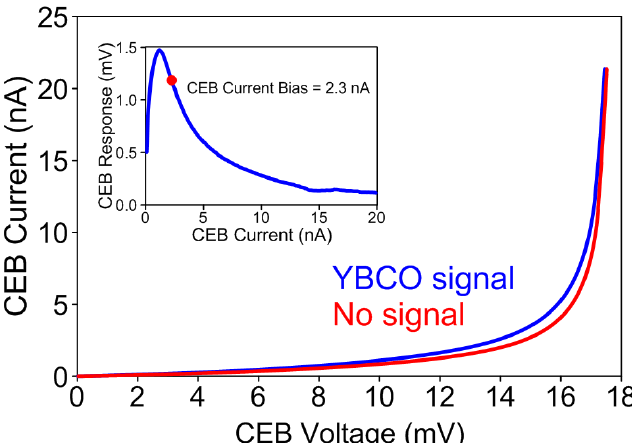
Figure 2. Current-voltage characteristic of bolometer for the case of no signal and under the YBCO JJ radiation. The inset: CEBs response as a function of bias current. The mark corresponds to the used bias.